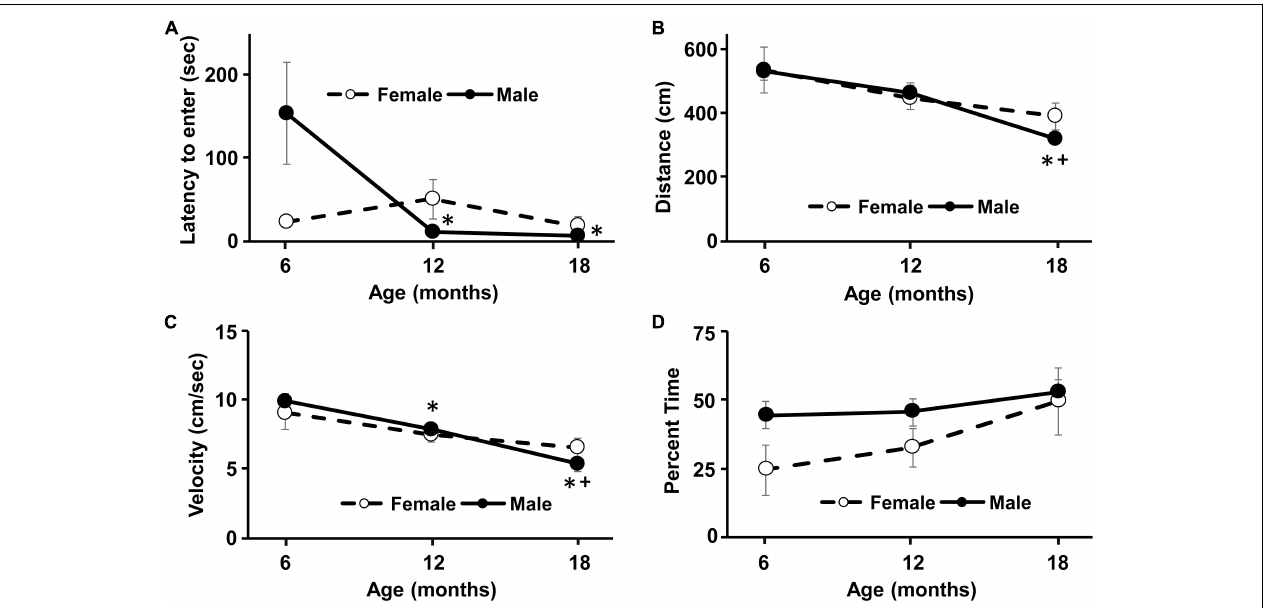
FIGURE 2 | Longitudinal change in response to a novel environment and activity in an open field. No sex difference was observed for any of the measures. (A) An age-related decrease in the latency to enter the novel environment was due to males, such that the latency to enter the novel environment decreased at 12 and 18 months compared to 6 months. Similarly, for the open field, the distance traveled (B) and the velocity of movement (C) decreased with age, due mainly to performance by males. (D) No age or sex difference was observed for the percent time in the inner region of the open field. Asterisks indicated a significant ( p < 0.05) difference from 6 months and + sign indicates a difference between 12 and 18 months for males.